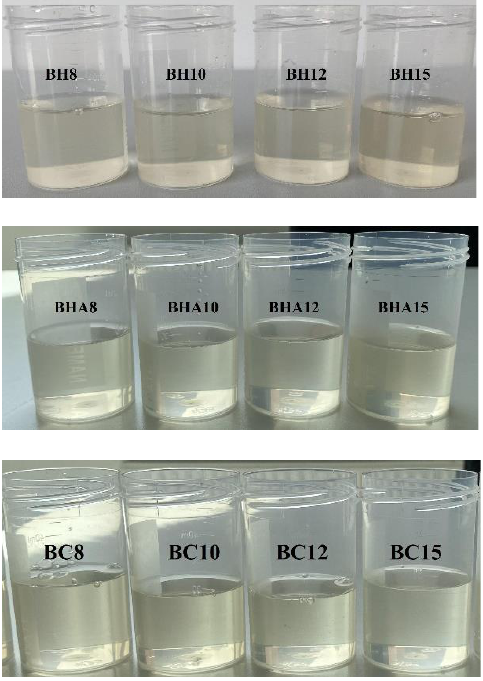
Figure 4. Ophthalmic formulations with balsam poplar buds extract after sterilization.